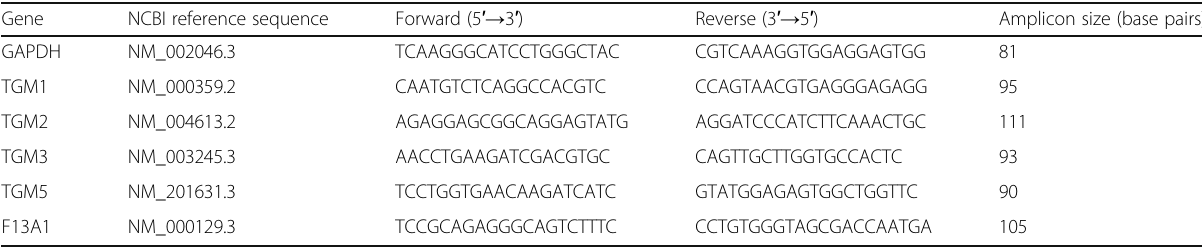
Table 1 Primer sequences used for qPCR